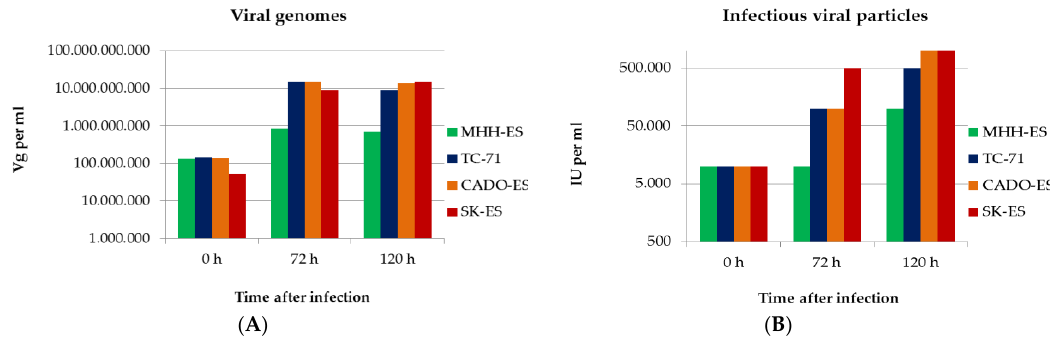
Figure 6. Ewing sarcoma cells are capable of active H-1PV replication. ( A ) Viral genomes in the supernatants of H-1PV-infected Ewing sarcoma cells were quantified by NS1-specific qPCR at the time points indicated; ( B ) Titers of infectious viral particles released into the supernatants of H-1PV-infected cells were quantified by propagation on NBK cells after serial dilution and detection of viral DNA on dot blots with a 32 P-labeled NS1-specific oligonucleotide probe.